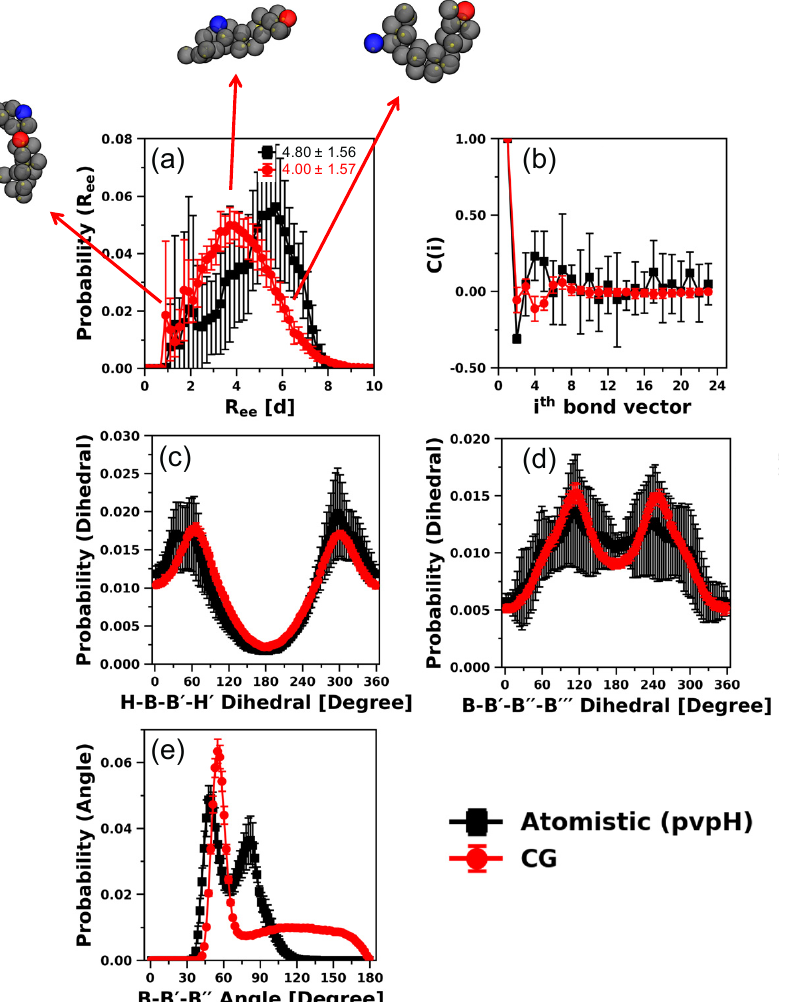
Figure 4. Comparison of distributions of ( a ) R ee distance (with ensemble average values in reduced units (d)), with CG simulation snapshots of pvpH chains included at various R ee with end beads color coded in red and blue, ( b ) bond-vector autocorrelation functions, ( c ) H-B-B (cid:48) -H (cid:48) dihedral, ( d ) B-B (cid:48) -B (cid:48)(cid:48) -B (cid:48)(cid:48)(cid:48) dihedral, and ( e ) B-B (cid:48) -B (cid:48)(cid:48) angle, for 24-mer pvpH chains, obtained from atomistic simulations and CG simulations (for the best performing case of attractive interaction between any two hydrogen bonding beads (H-H), ε HH , in the CG model equal to 7 kT and H-B-B (cid:48) -H (cid:48) torsional constraint simultaneously imposed). The standard deviations are computed from the means of 5 independent trials for atomistic simulations and 10 independent trials for CG simulations and the lines joining the symbols in parts ( a , c – e ) are drawn to guide the